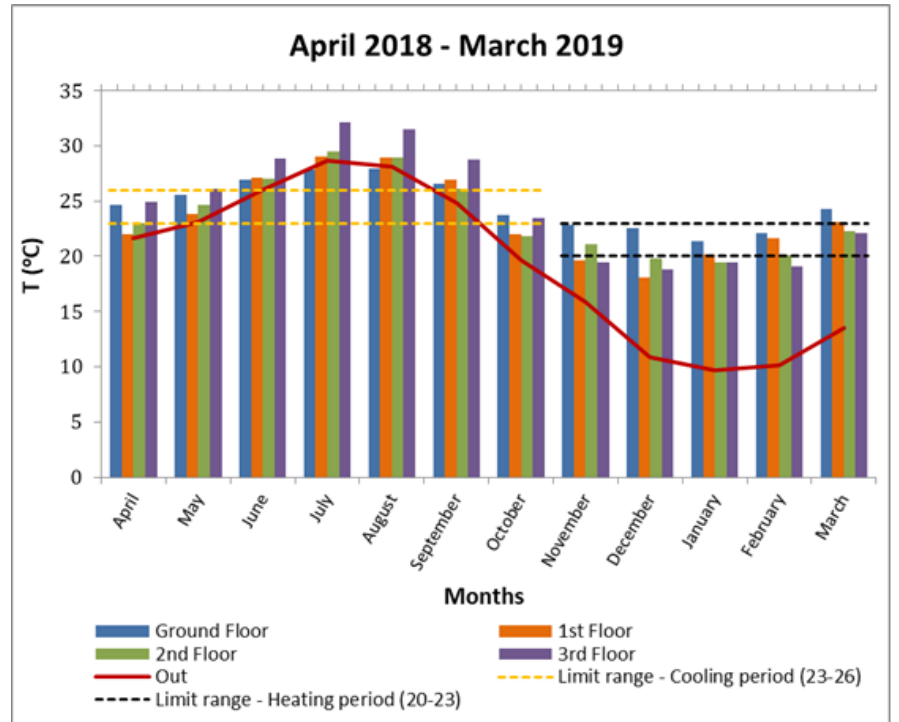
Figure 3. Monthly average T ( ◦ C) levels within the B FEPA building along with the respective limits. Energies 2019 , 12 , x FOR PEER REVIEW